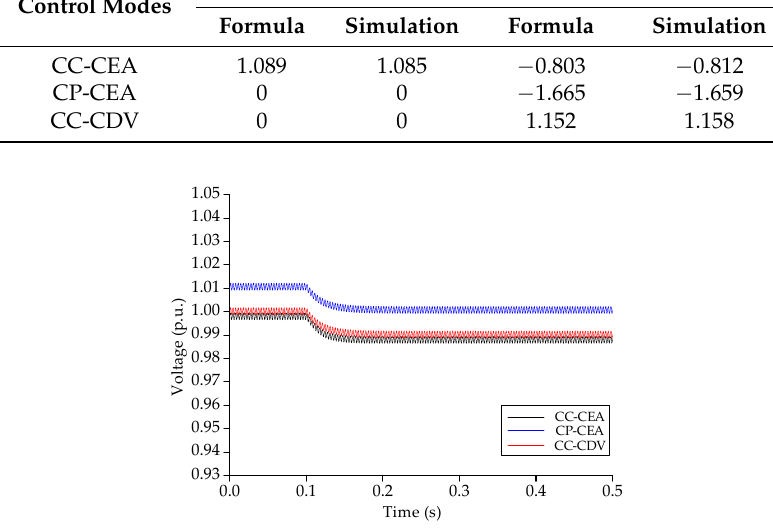
Figure 8. Voltage change of converter bus under different control modes.